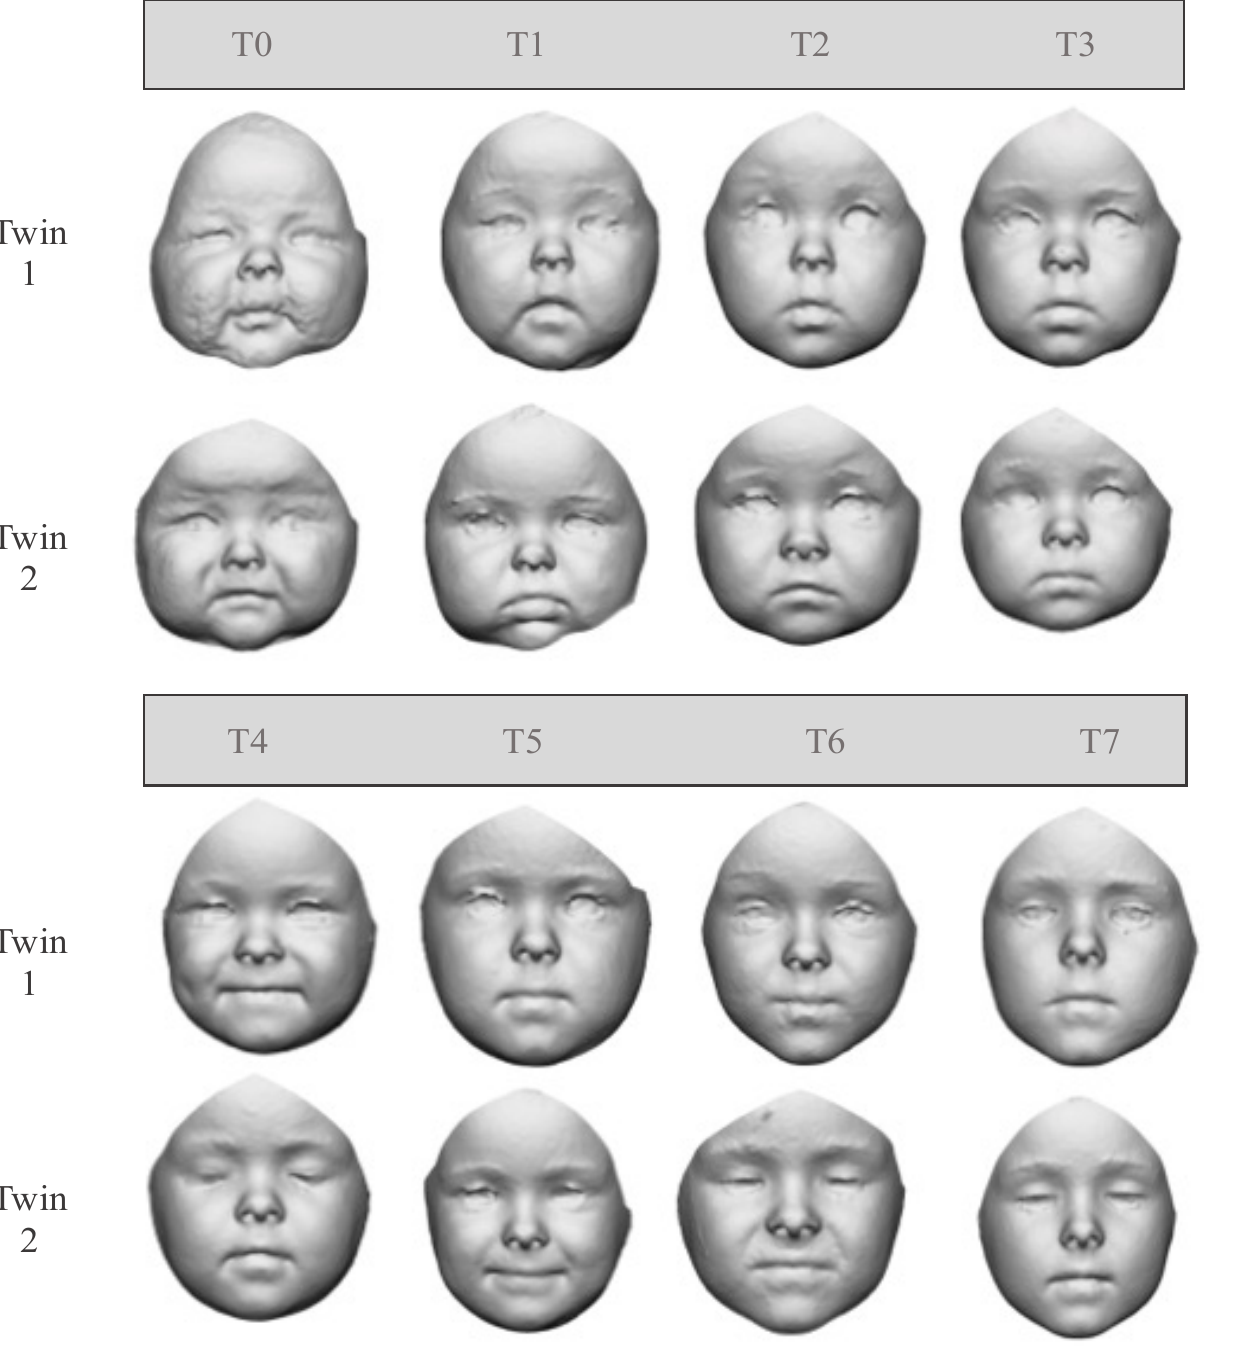
Figure 1. Details of each FAI from the twin sisters at each time of acquisition: T0 = 6 months, T1 = 9 months, T2 = 13 months, T3 = 17 months, T4 = 26 months, T5 = 36 months, T6 = 50 months, and T7 = 63 months. Twin 1: first born; Twin 2: second born.